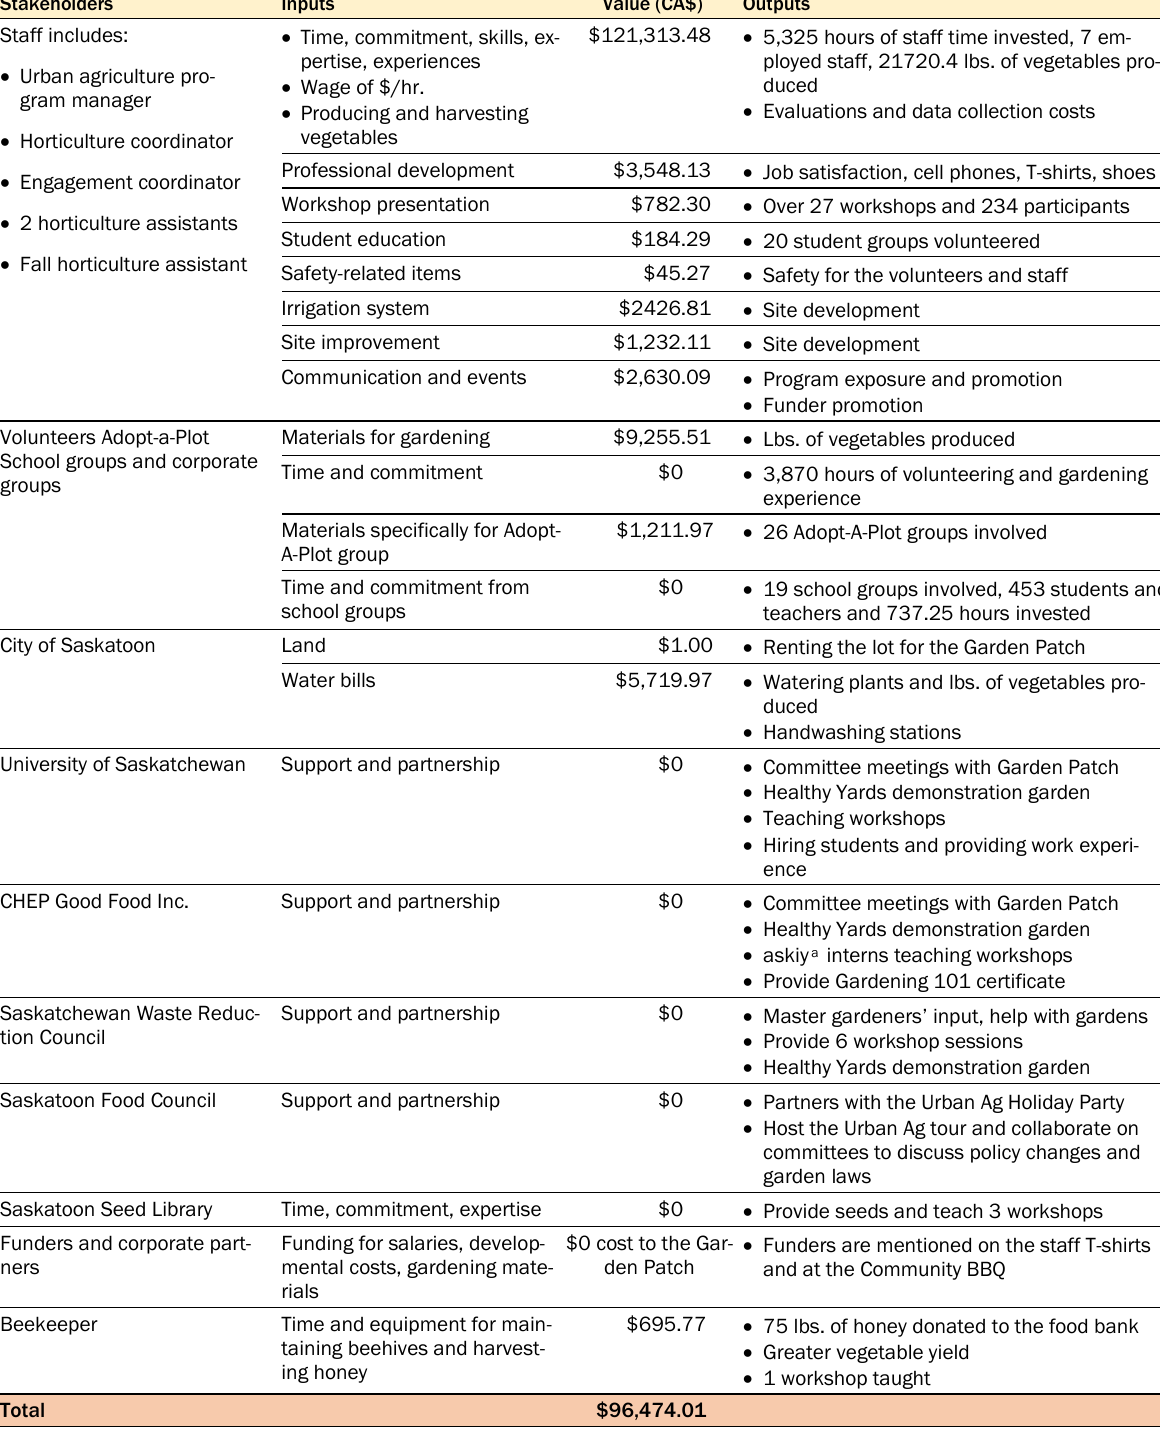
Table 2. Inputs and Outputs